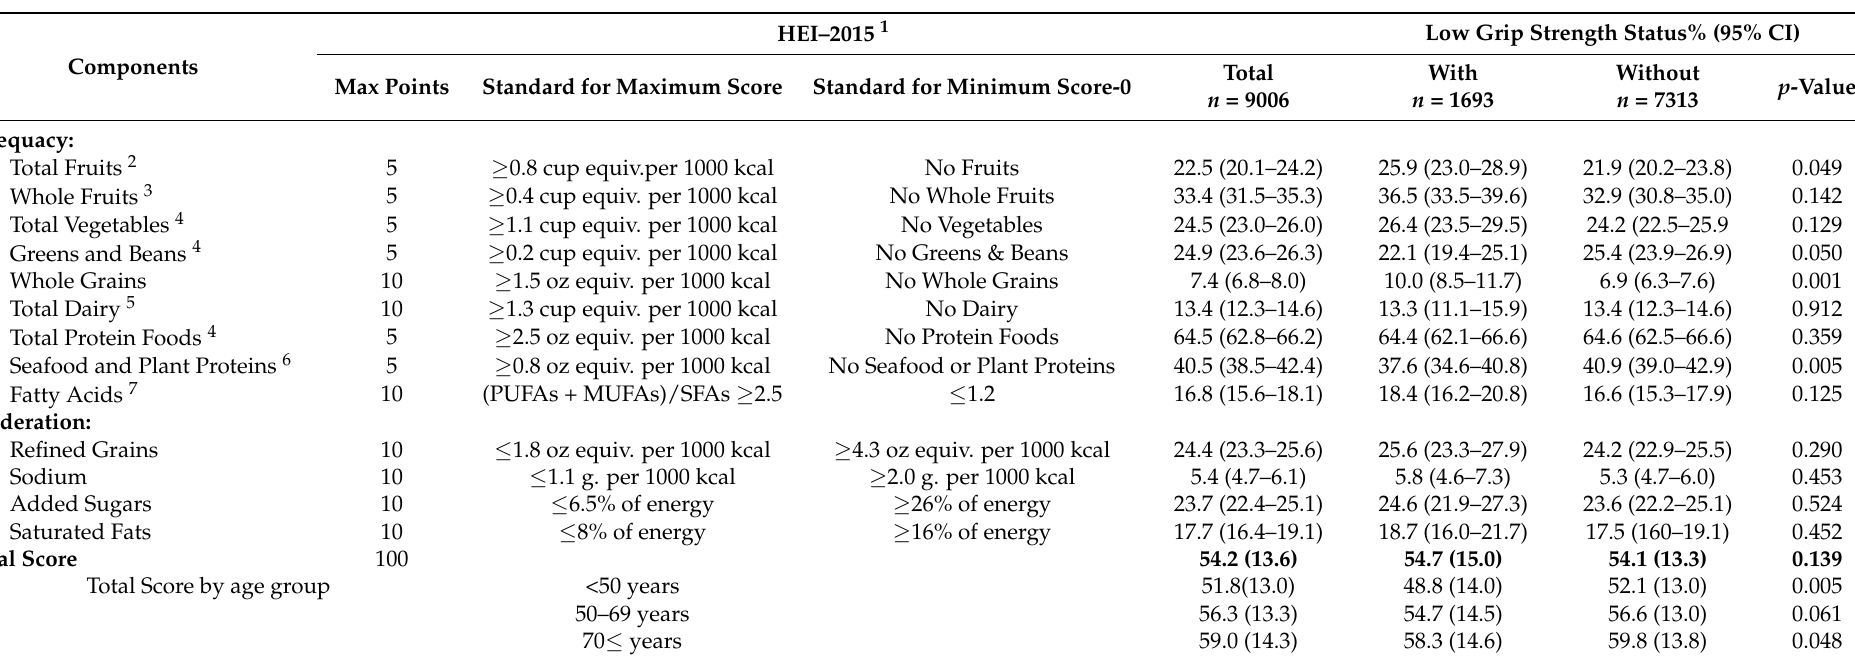
Table 2. Weighted proportions of individuals who received maximum score in each of the Health Eating Index-2015 (HEI-2015) component, and weighted mean of HEI-2015 total